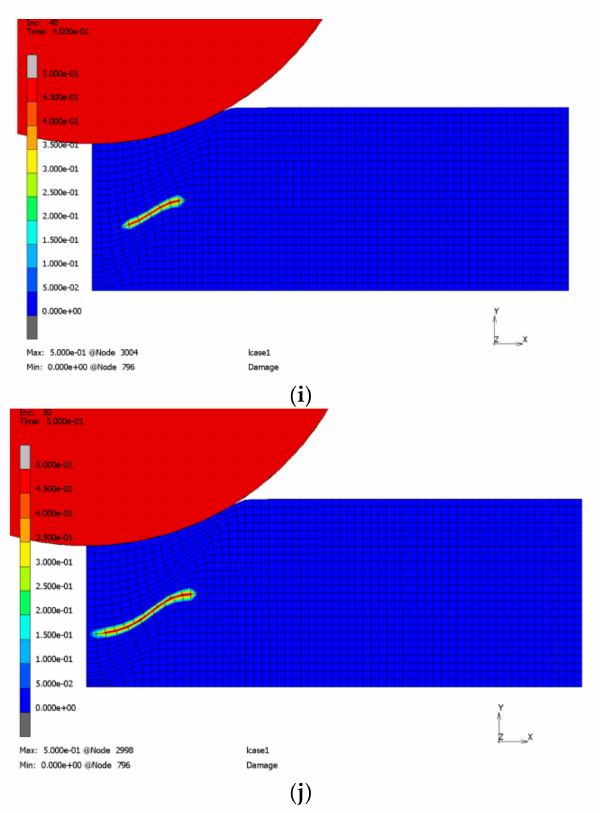
Figure 16. Indentation test: Joining zone damage: increment 0 ( a ), 10 ( b ), 20 ( c ), 30 ( d ), 36 ( e ), 37 ( f ), 38 ( g ), 39 ( h ), 40 ( i ), 50 ( j